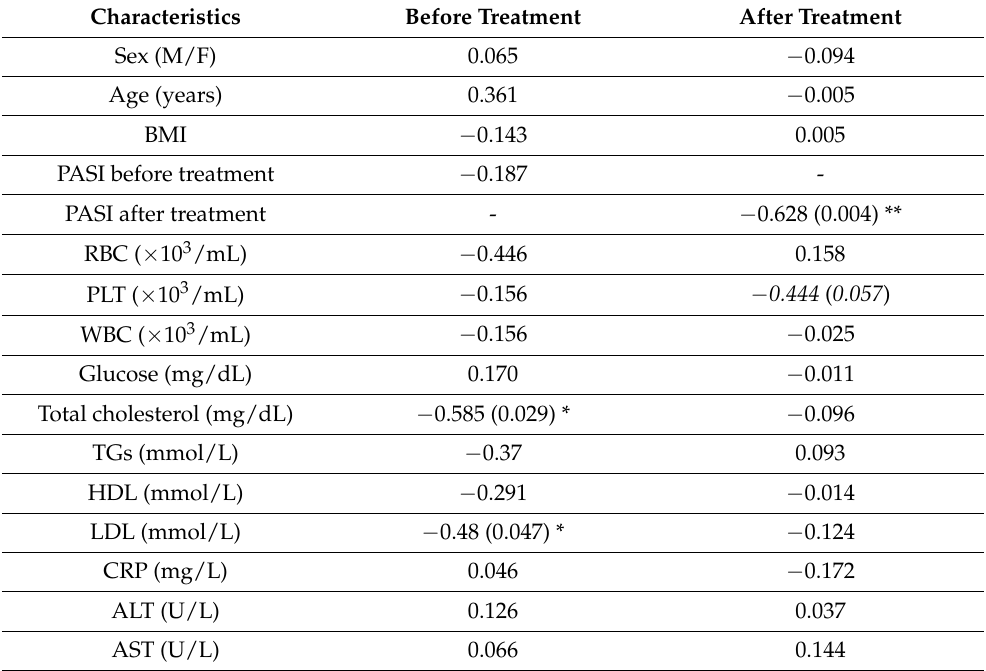
Table 2. The presence of correlations between ANGPTL8 serum concentrations and studied param- eters before and after treatment in psoriatic patients.